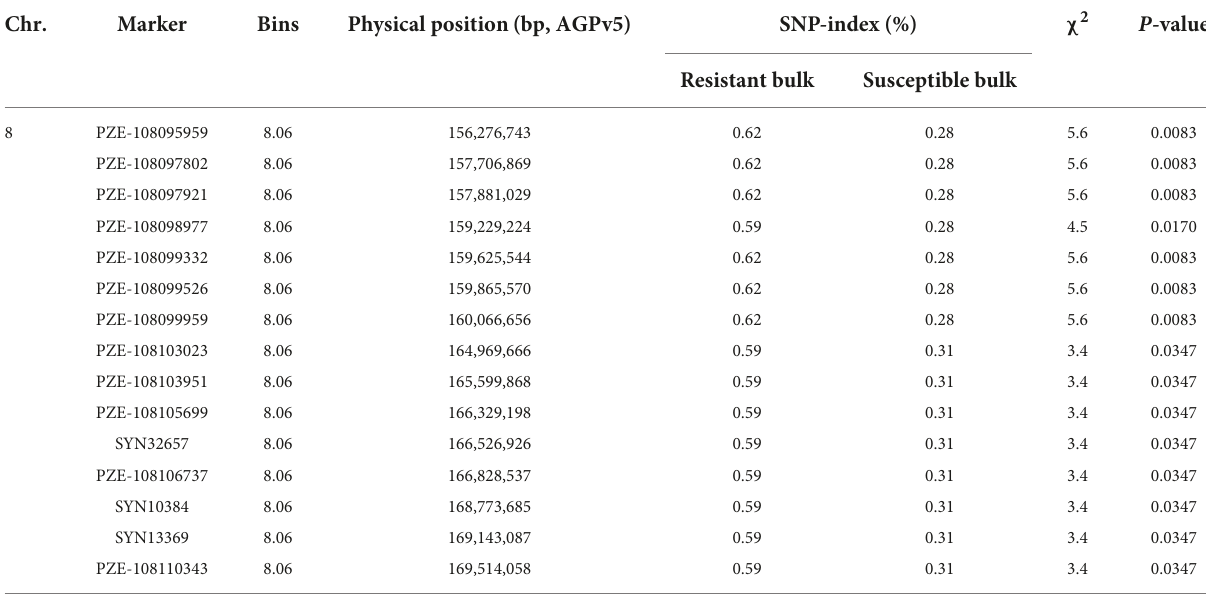
TABLE 3 SNP markers in bin 8.06 significantly associated with NCLB resistance.